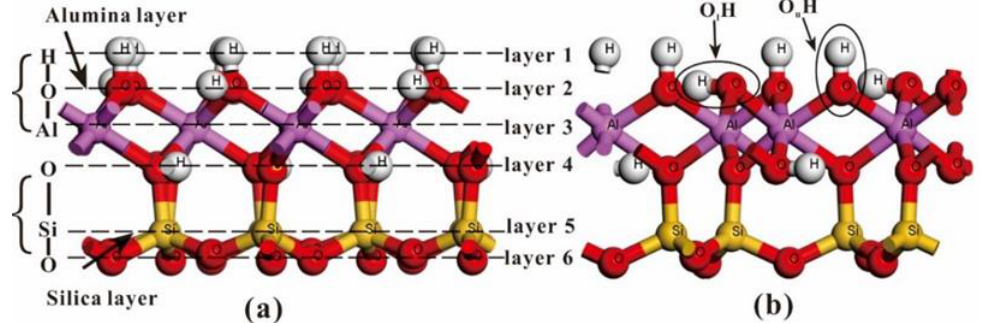
Figure 1. ( a ) the main view of kaolinite single layer model. Each kaolinite single layer contains six atomic “sublayers” which are H–O–Al–O–Si–O from top to bottom, the upper three layers constitute the “Alumina layer” and the lower three layers constitute the “Silica layer”; ( b ) the hydroxyl which parallel to the surface of kaolinite-“lying” hydroxyl (OlH), the hydroxyl which perpendicular to the surface of kaolinite-“upright” hydroxyl (OuH).